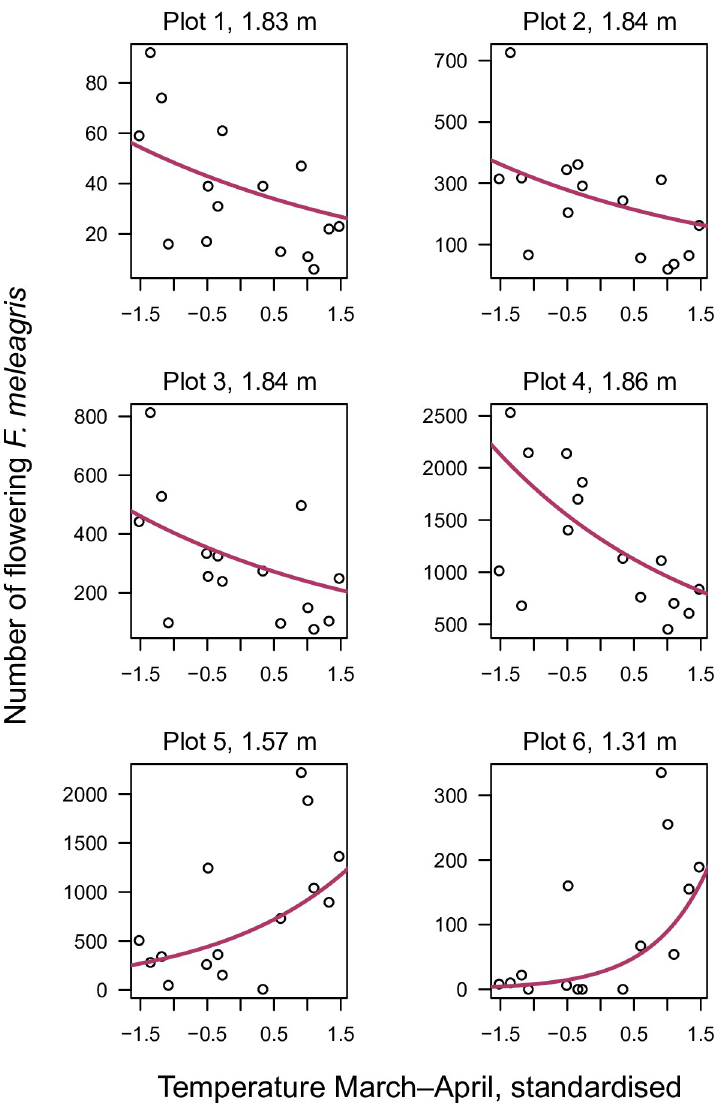
Fig 9. Number of flowering Fritillaria meleagris in sixteen years between 1938 and 2021 in plots 1–6 along Profile 1 (Fig 1) in relation to elevation and mean temperature in March–April. The lines show the number of flowers predicted by the generalised linear mixed model. Elevation (m a.s.l.) is given for each plot. Statistical analysis is summarised in S8